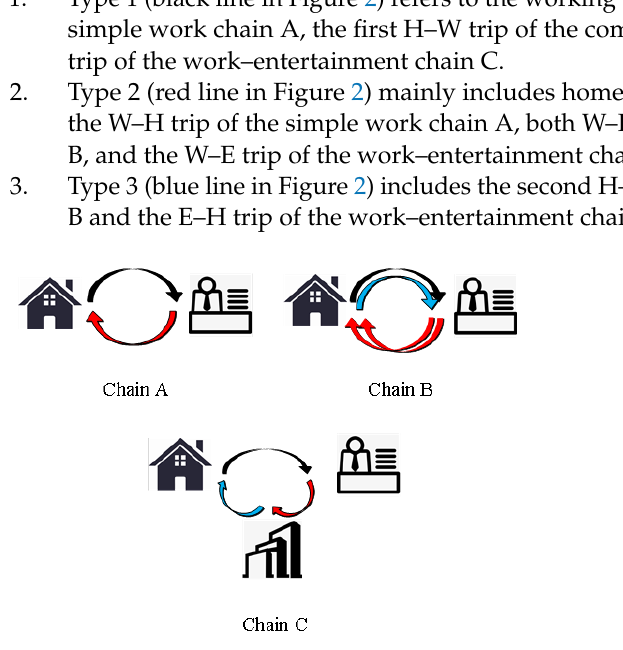
Figure 2. Trip types in different travel